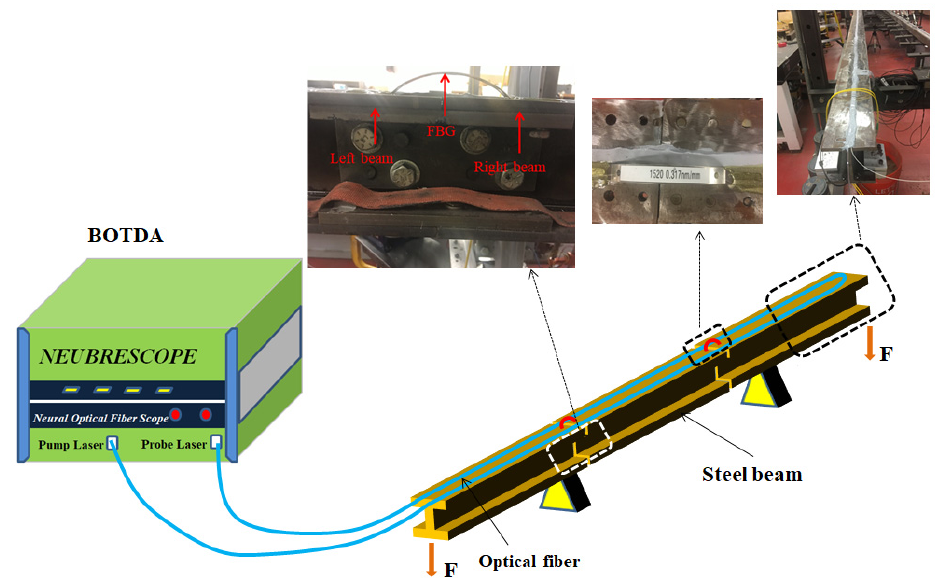
Table 1. Mechanical parameters of distributed optical fiber.